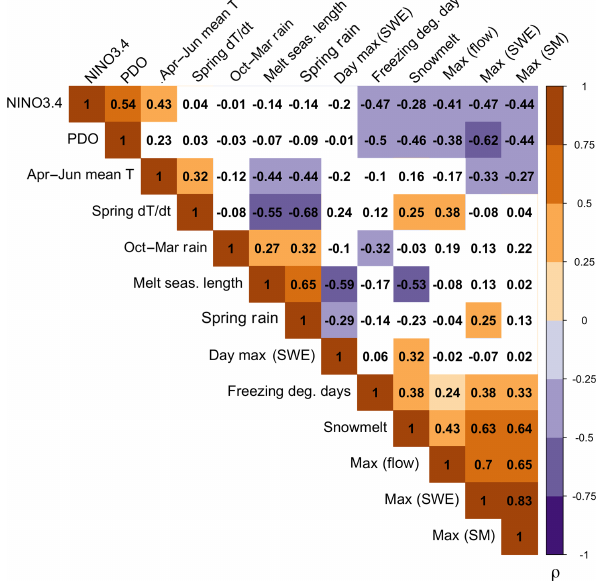
Figure 6. Correlogram of all observed and VIC-simulated vari- ables, averaged over the Fraser Basin within the common period of records, 1955–2004. All values are Spearman rank correlation coefficients, and coloured squares indicate significant correlations at the p < 0.1 level. A hierarchical clustering algorithm has been applied to group like-with-like correlations.